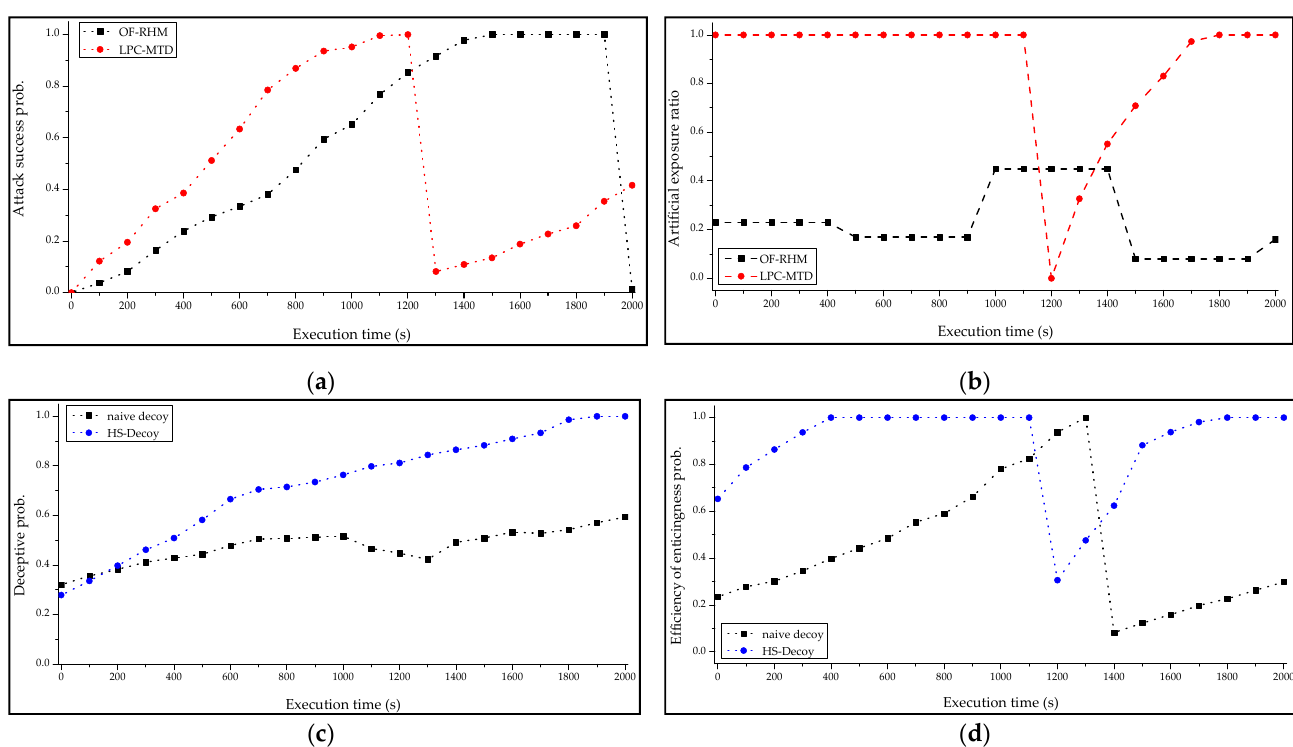
Figure 7. Comparison of results of the existing deception concept and the proposed models. ( a ) Attack success probability between OF-RHM [59]-based naïve MTD and LPC-MTD, ( b ) artificial organizational exposure ratio, ( c ) deceptive probability between naïve decoy and HS-Decoy, and ( d ) efficiency of enticingness probability.